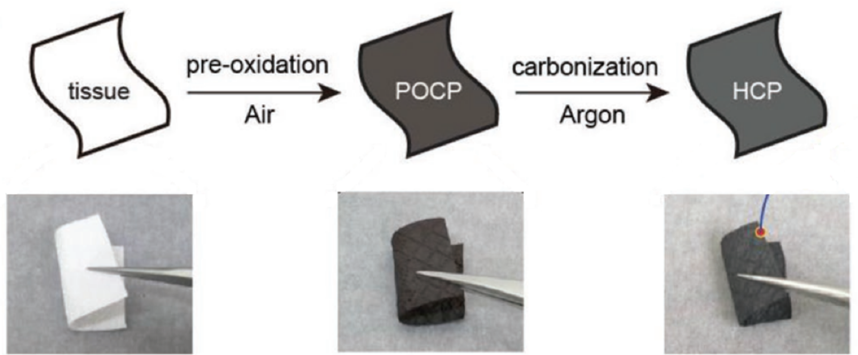
Figure 18. ( a ) Schematic illustration of three-electrode SIB, which use Na foil as the reference electrode [134]. ( b ) Schematic diagram of chemical pre-sodiation progress. ( c ) Cycling stability of HC and Na x HC electrodes at 0.05A g − 1 [135].